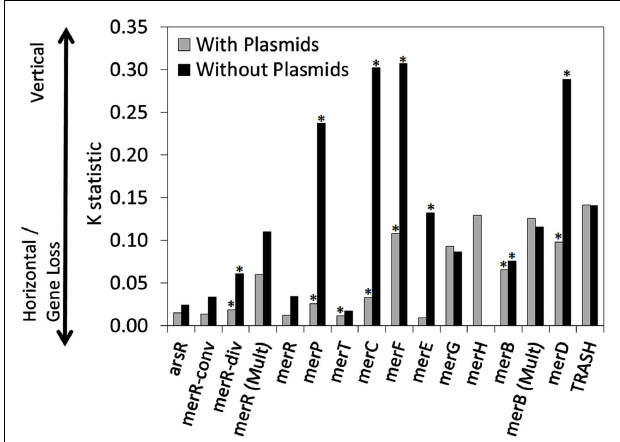
FIGURE 5 |The K -statistic associated with individual mer functions, when mapped on the rate smoothed MerA phylogenetic tree. K -statistics were calculated for mer functions encoded on operons that were either chromosomal encoded (e.g., without plasmids) or that were chromosomal and plasmid encoded (with plasmids). K values that were statistically significant ( p -value < 0.05) are indicated with an asterisk. Low K values are suggestive of a strong tendency for the gene to be subjected to LGT or gene loss. In contrast, high K values are suggestive of vertical transmission of the